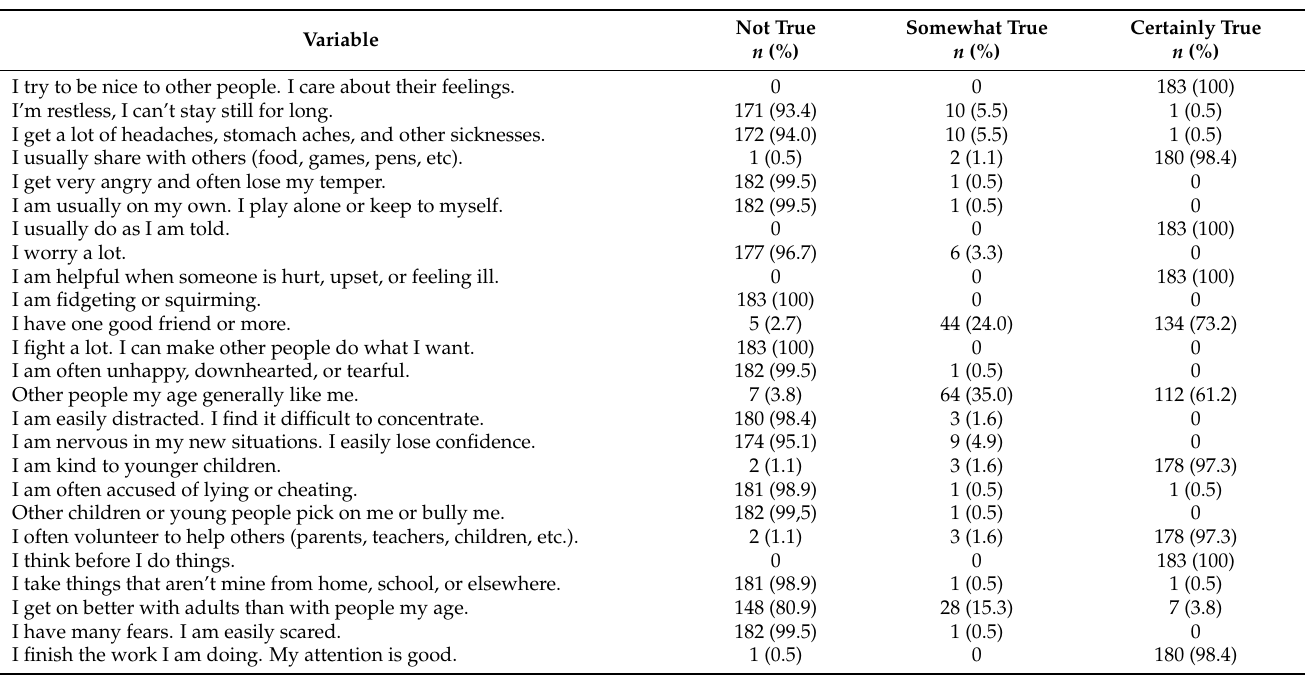
Table 5. Strengths and difficulties.